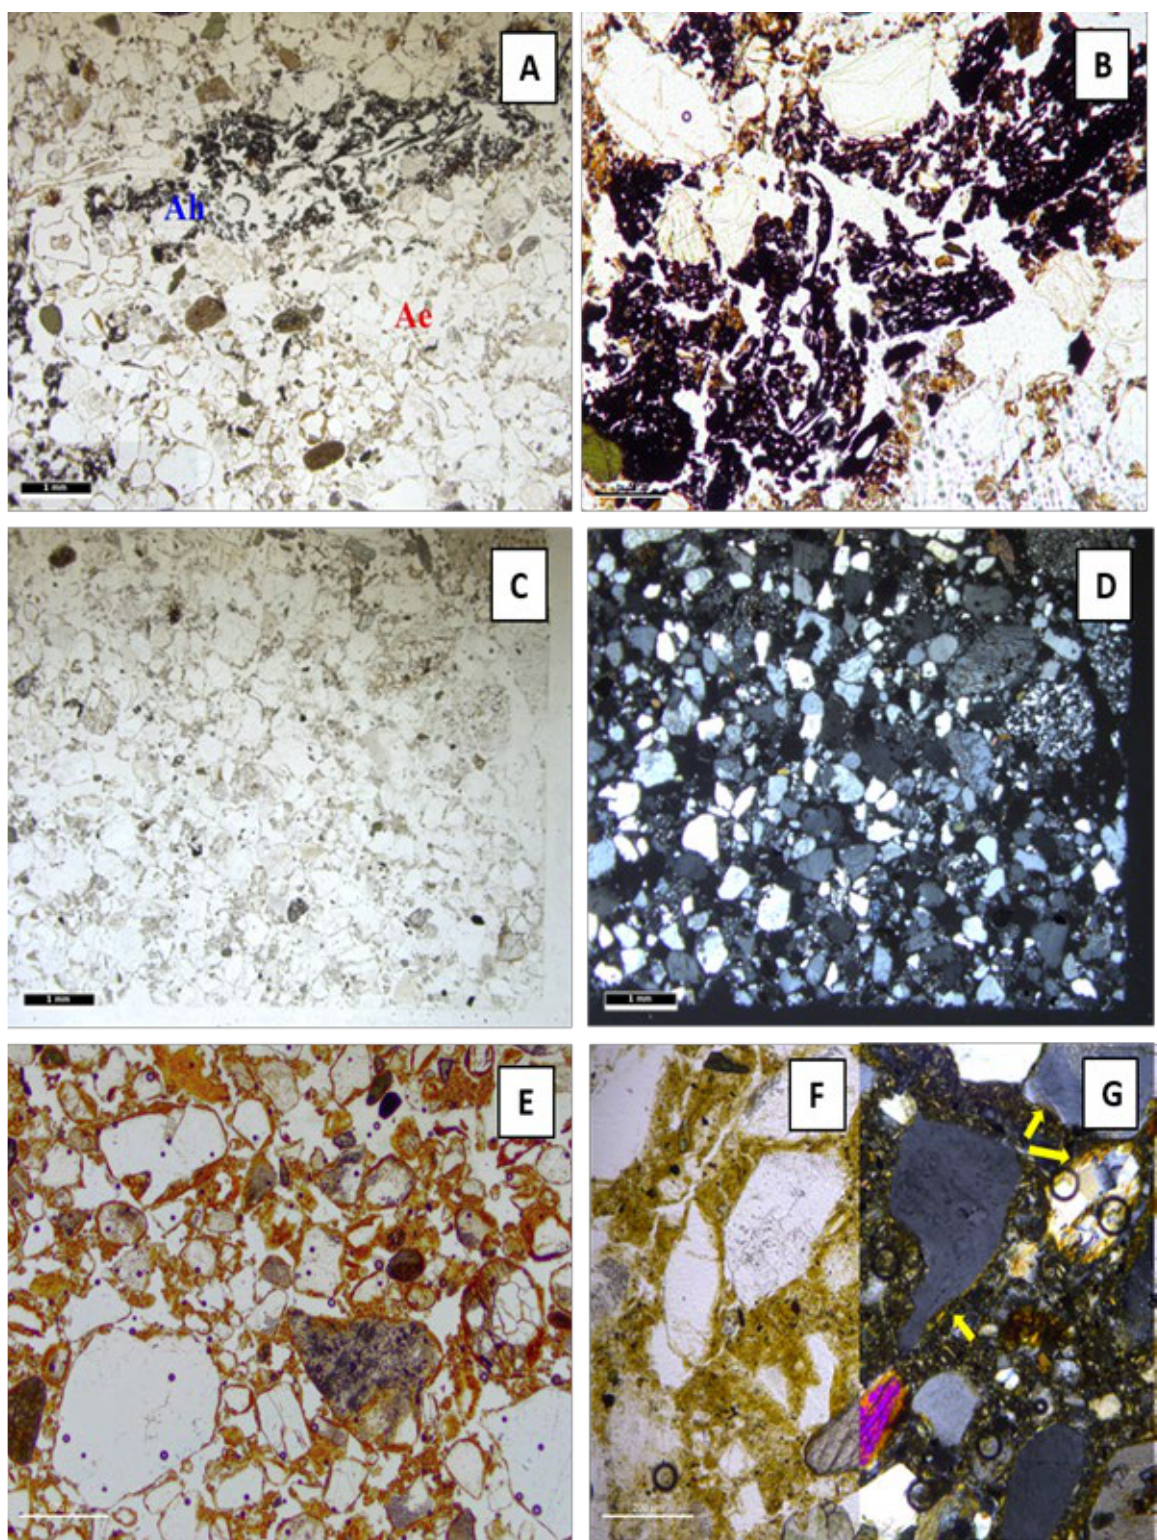
Figure 7. Microstructure of the natural sediments at the Fort Odanak site (CaFe-7). ( A ) Microstruc- ture of the brunisol’s organic horizon (Ah). A thin layer of dark organic matter with highly decom- posed vegetal remains and fungi material overlies an eluviated mineral horizon (Ae). (Layer 12A13, ⁓ 57 cm/surface, PPL). ( B ) Close-up of the organic material within the Ah (Layer 12A13, ⁓ 57 cm/sur- face, PPL). ( C ) Microstructure of the eluviated horizon (Ae) with generally uncoated or very thinly coated mineral grains. Intergranular plasma is greyish, due to iron oxide depletion, and almost en- tirely mineral (Layer 12A13, ⁓ 57 cm/surface, PPL). ( D ) Same in XPL. The b-fabric appears undiffer- entiated and characteristic interference colors displayed by calcitic ash crystals are absent from the plasma. ( E ) Pellicular microstructure of the brunisolic B horizon. Mineral grains have a thick coating of fine oxidized plasma. Plasmic material is yellowish as a result of clay and iron oxide accumula- tion, and very few organic fragments are observed in the sediments (Layer 12A14, ⁓ 56 cm/surface, PPL). ( F ) Detail of the fine mineral plasma in the brunisolic B horizon (Layer 12A14, ⁓ 56 cm/surface, PPL). ( G ) Same in XPL. Note the speckled and in some places weakly granostriated (yellow arrows) b-fabric of the matrix. PPL, polarized microscope in plane-polarized light; XPL, crossed polarized light.